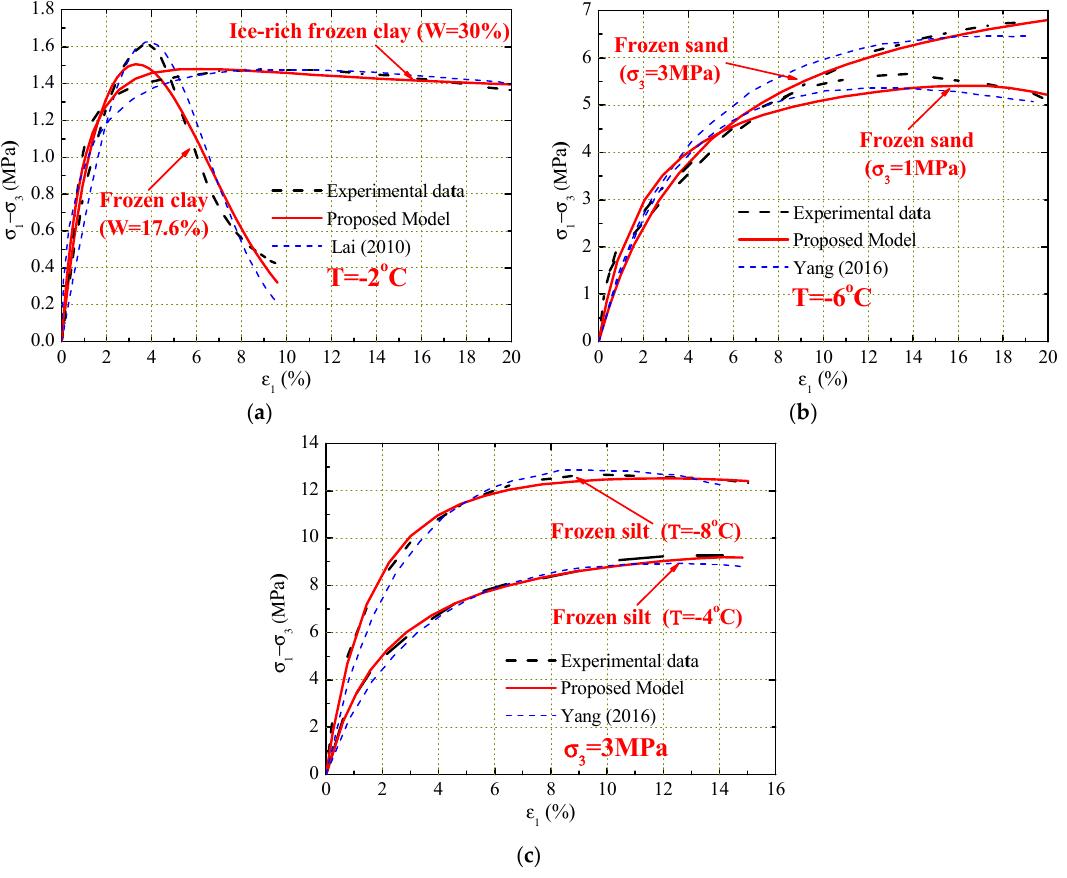
Figure 10. Comparison of the experimental and predicted stress–strain curves. ( a ) water content; ( b ) confining pressure; ( c ) temperature.